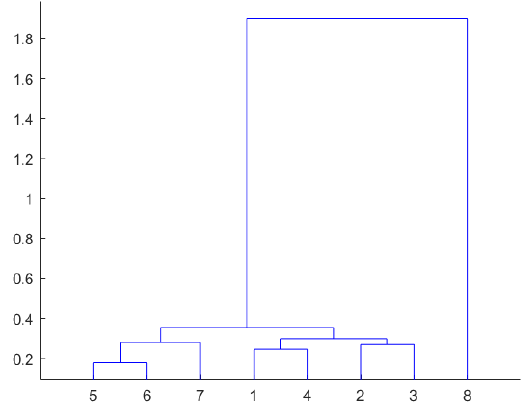
Figure 3. The result of hierarchical